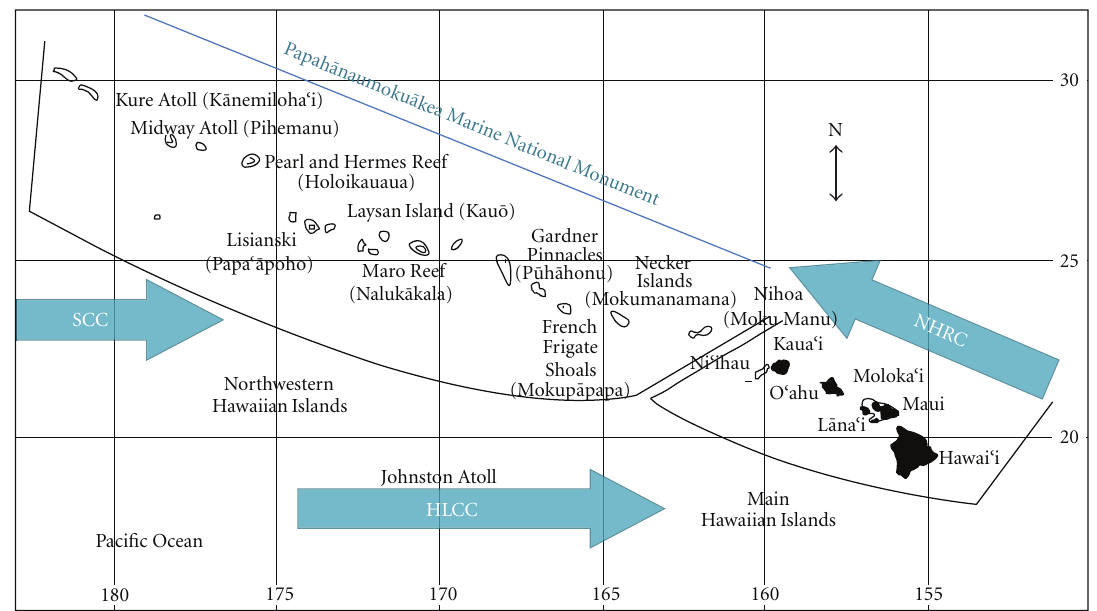
Figure 1: Map of the Hawaiian Archipelago with major currents denoted: the North Hawaiian Ridge Current (NHRC), the Hawaiian Lee Countercurrent (HLCC), and the Subtropical Countercurrent (SCC). The lines around the two regions of the archipelago highlight the islands, atolls, and banks protected within the Papah¯anaumoku¯akea Marine National Monument in the Northwestern Hawaiian Islands (NWHI) and the inhabited high islands of Main Hawaiian Islands (MHI) with each of the 15 primary target areas for collection labeled. For purposes of this analysis, the islands of L¯ana‘i, Maui & Moloka‘i are treated as a single site within the Maui Nui complex of the MHI. Listed from northwest to southeast, these are: Kure Atoll (K¯anemiloha‘i), Midway Atoll (Pihemanu), Pearl and Hermes Reef (Holoikauaua), Lisianski (Papa‘¯apoho), Laysan Island (Kau¯o), Maro Reef (Naluk¯akala), Gardner Pinnacles (P¯uh¯ahonu), French Frigate Shoals (Mokup¯apapa), Necker Island (Mokumanamana), Nihoa (Moku Manu), Ni‘ihau, Kaua‘i, O‘ahu, Maui Nui, and